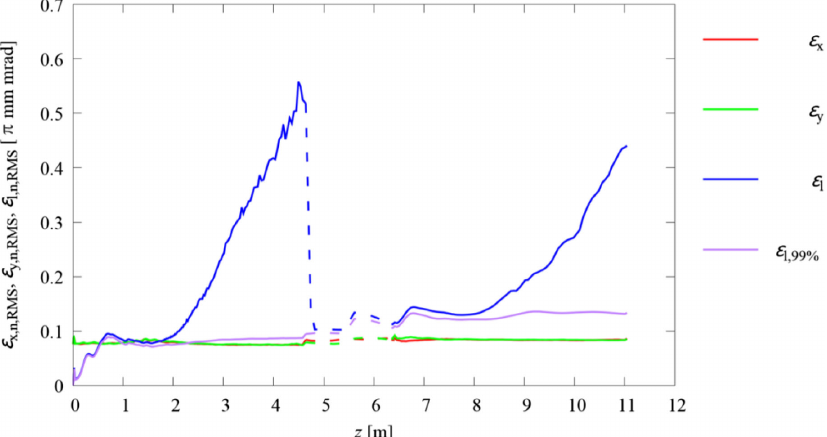
FIG. 13. Emittance evolutions along the linac with an MEBT (the solid lines for the RFQs, the dash lines for the MEBT section, the purple curve for 99% of the beam, respectively).